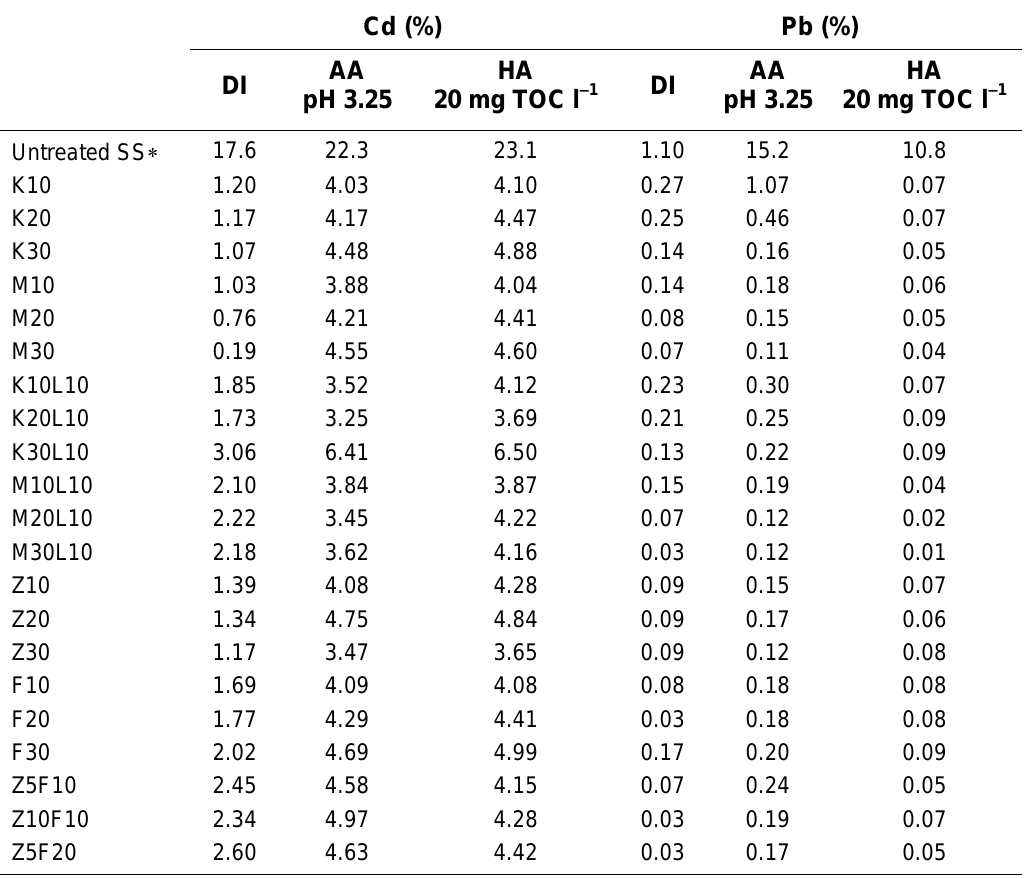
Total Cumulative Fraction (%) of Cd and Pb Leached in ANS 16.1 using